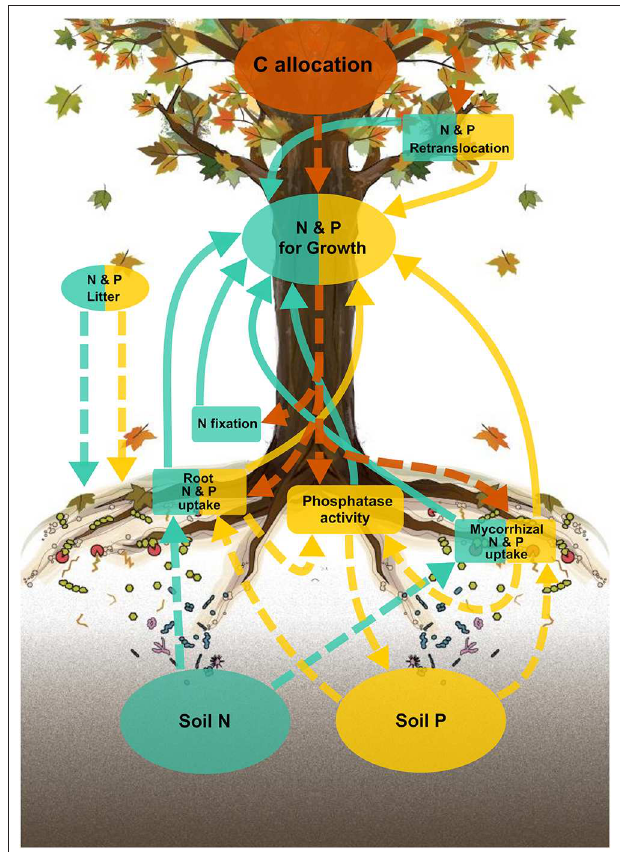
FIGURE 1 | Schematic diagram of the active uptake pathways for the FUN 3.0 model. Carbon (C), nitrogen (N), and phosphorus (P) pools and uptake pathways are colored either orange, blue-green, or yellow, respectively. Boxes represent nutrient uptake pathways (either N or P), and circles represent C, N, and P pools. Solid lines represent N and P acquired for growth, and dashed lines represent C, N, and P allocated from associated pools.